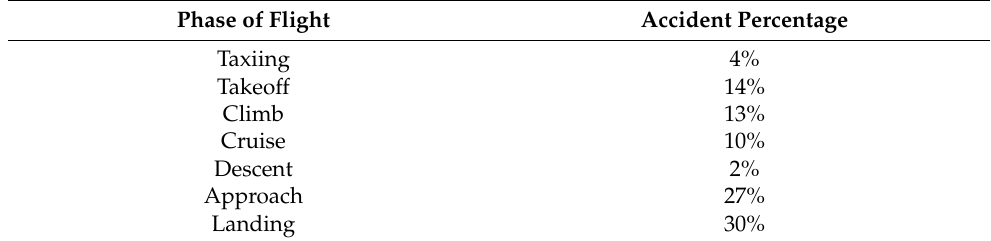
Table 1. Accident shares of each phase of flight